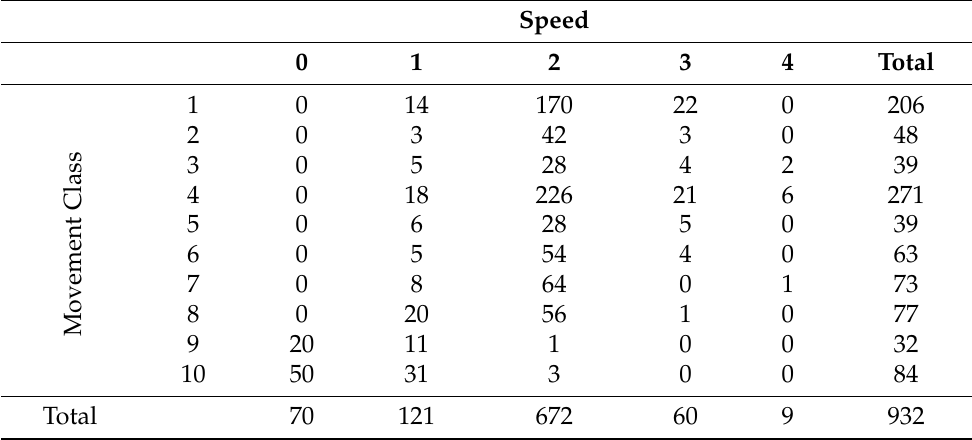
Table 6. Movement class compared to